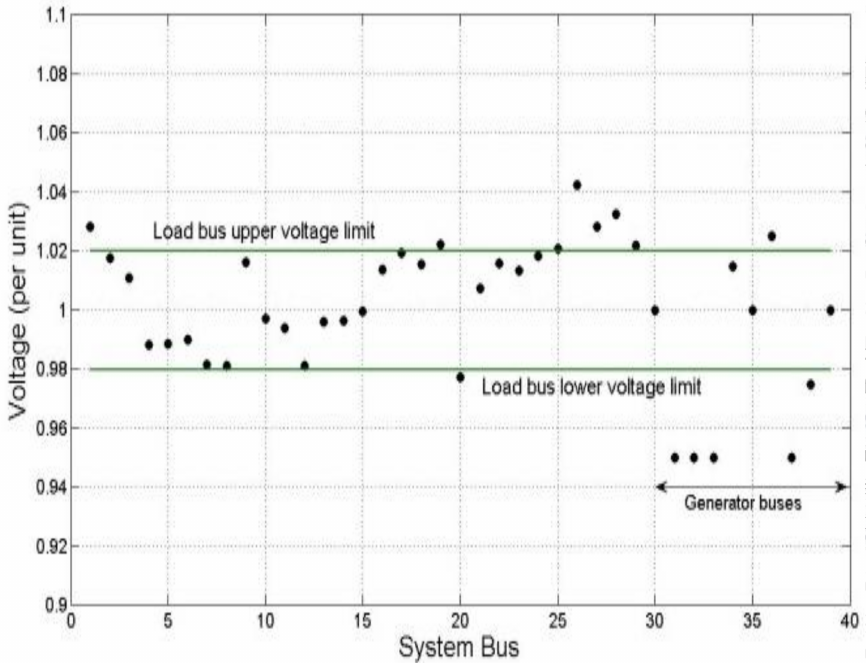
Figure 9. The 39-bus system voltage profile after game-control algorithm was